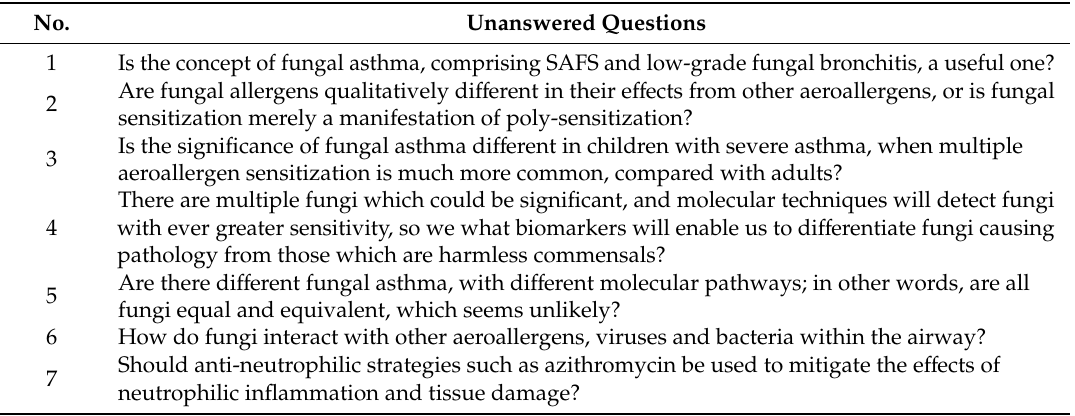
Table 2. Unanswered questions in the field of fungal